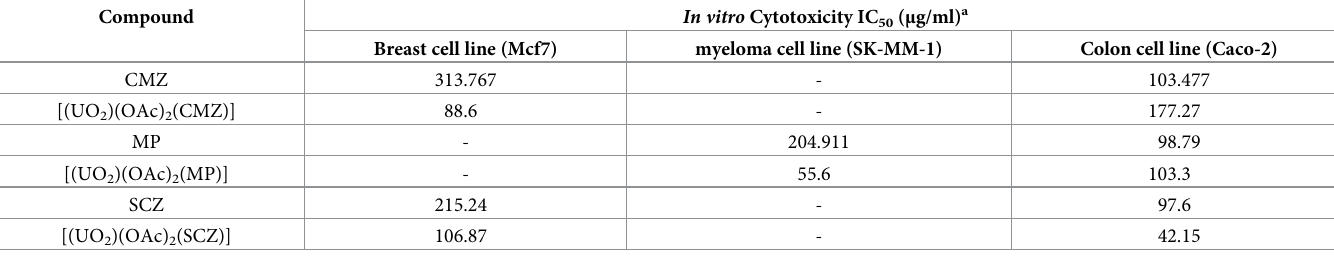
Table 7. Cytotoxic activity of the three free drugs and their metal complexes against three human tumor cell lines.